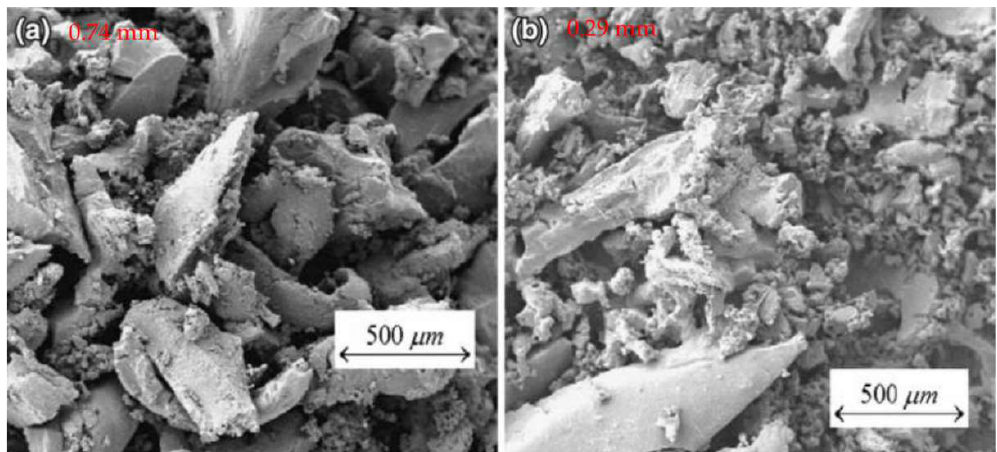
Figure 1. Microscopic image of elastic rubber particles. ( A ) Conventional SEM. ( B ) Field emission SEM at room temperature. ( C ) Transmission electron micrograph (TEM) of single rubber particles [49].